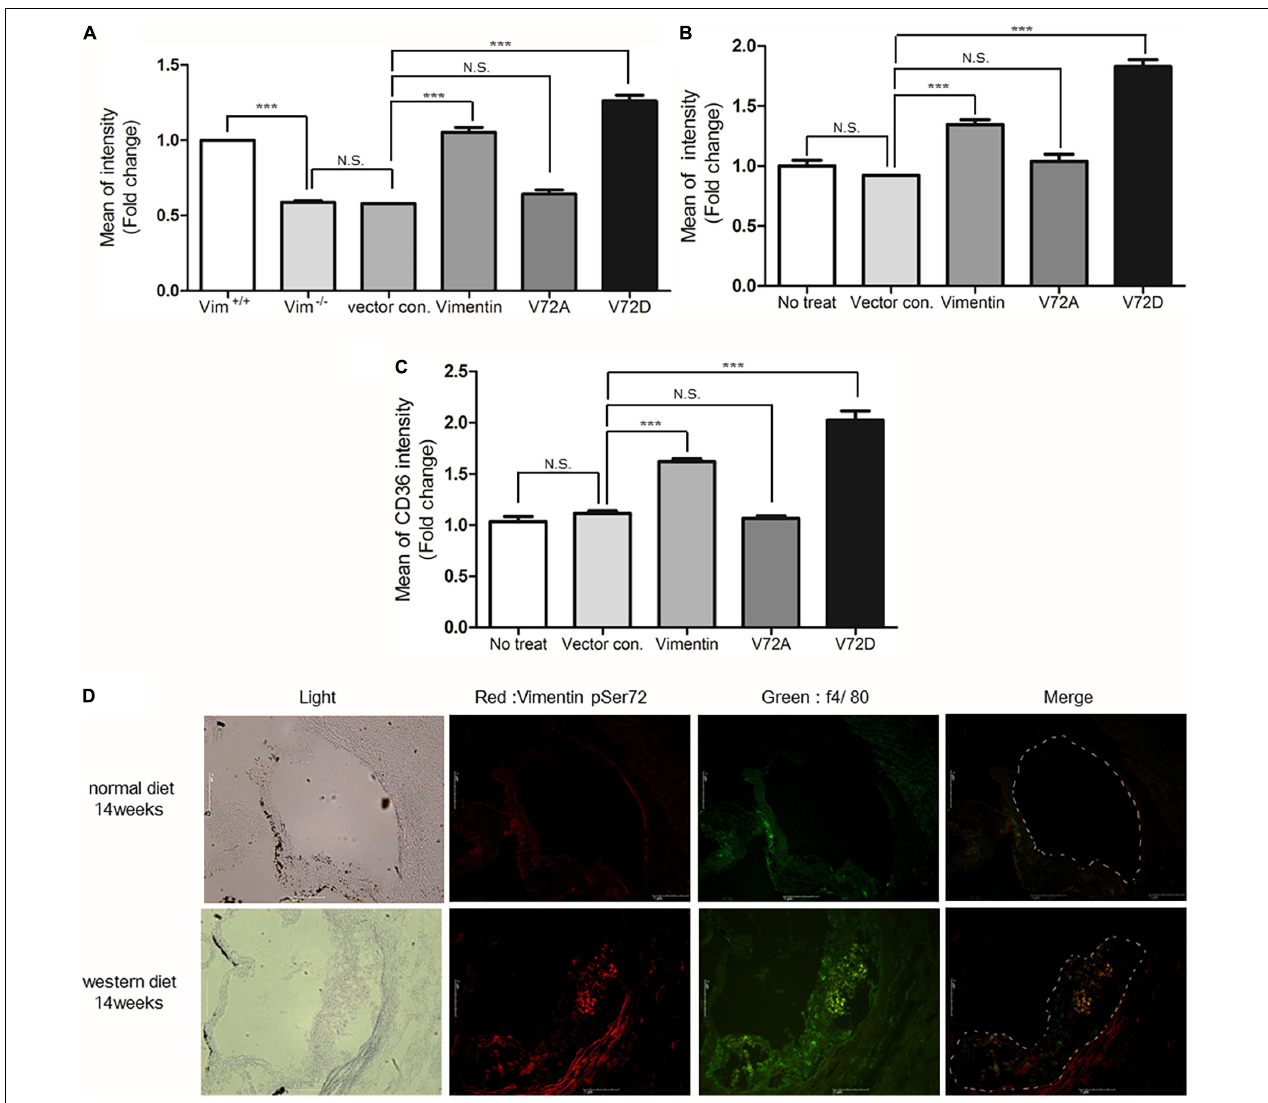
FIGURE 6 | Vimentin (Ser72) phosphorylation induced by oxLDL is required for the uptake of oxLDL. (A) Flow cytometry. Fluorescence intensities of diI-oxLDL-treated Vim − / − BMDM. Cells were transfected with vectors for vimentin or vimentin mutants. (B) Flow cytometry. Geometric mean fluorescence intensities of diI-oxLDL-treated SW13 cells. Cells were transfected with vectors for vimentin or vimentin mutants. (C) Measurement of membrane CD36. Vim − / − BMDM were transfected with vimentin or mutant vimentin vectors. Stabilized macrophages were stained with APC conjugated anti-CD36 antibody and analyzed using flow cytometry. (D) The representative immunohistochemistry images of aortic sinuses of Ldlr − / − mice fed a normal diet for 14 weeks or western diet for 14 weeks. Both samples were stained with antibody against phosphorylated vimentin (Ser72) (Dylight 594; Red) and antibody against f4/80 (Alexa 488; Green), a macrophage marker. Scale bars represent 1 µ m. N.S. not significant, *** p <